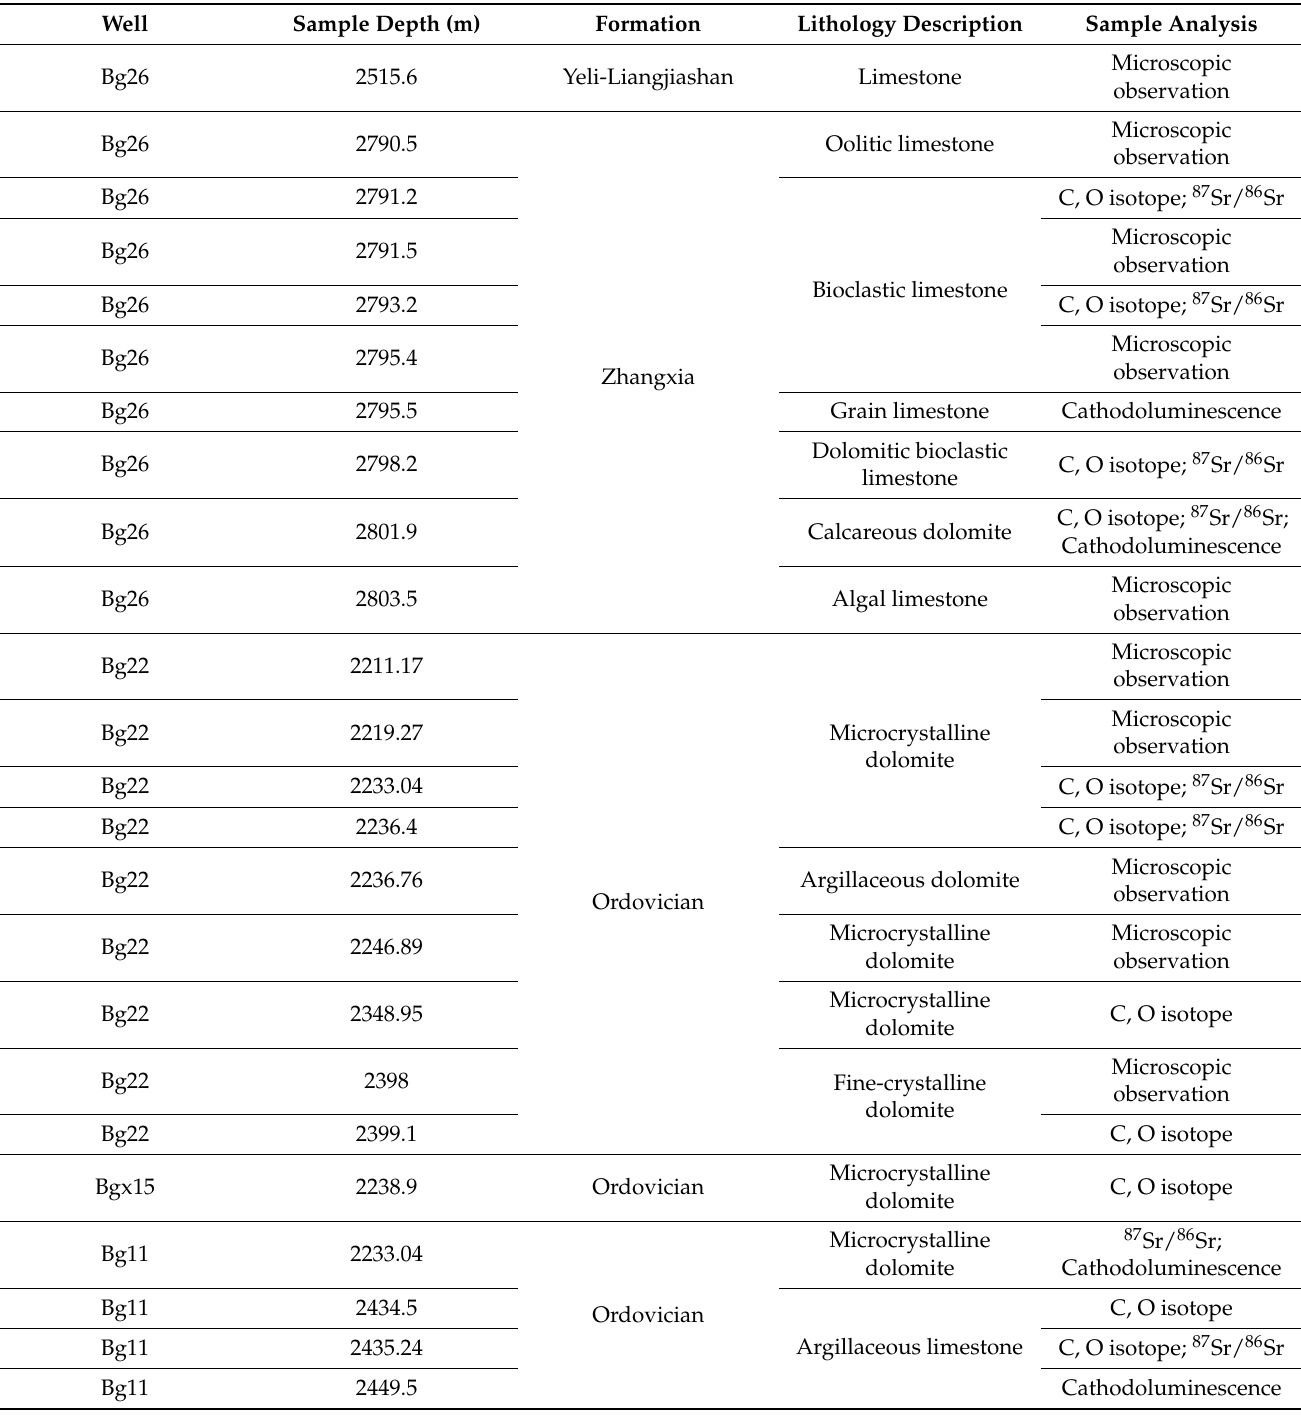
Table 1. Information on the samples used in this